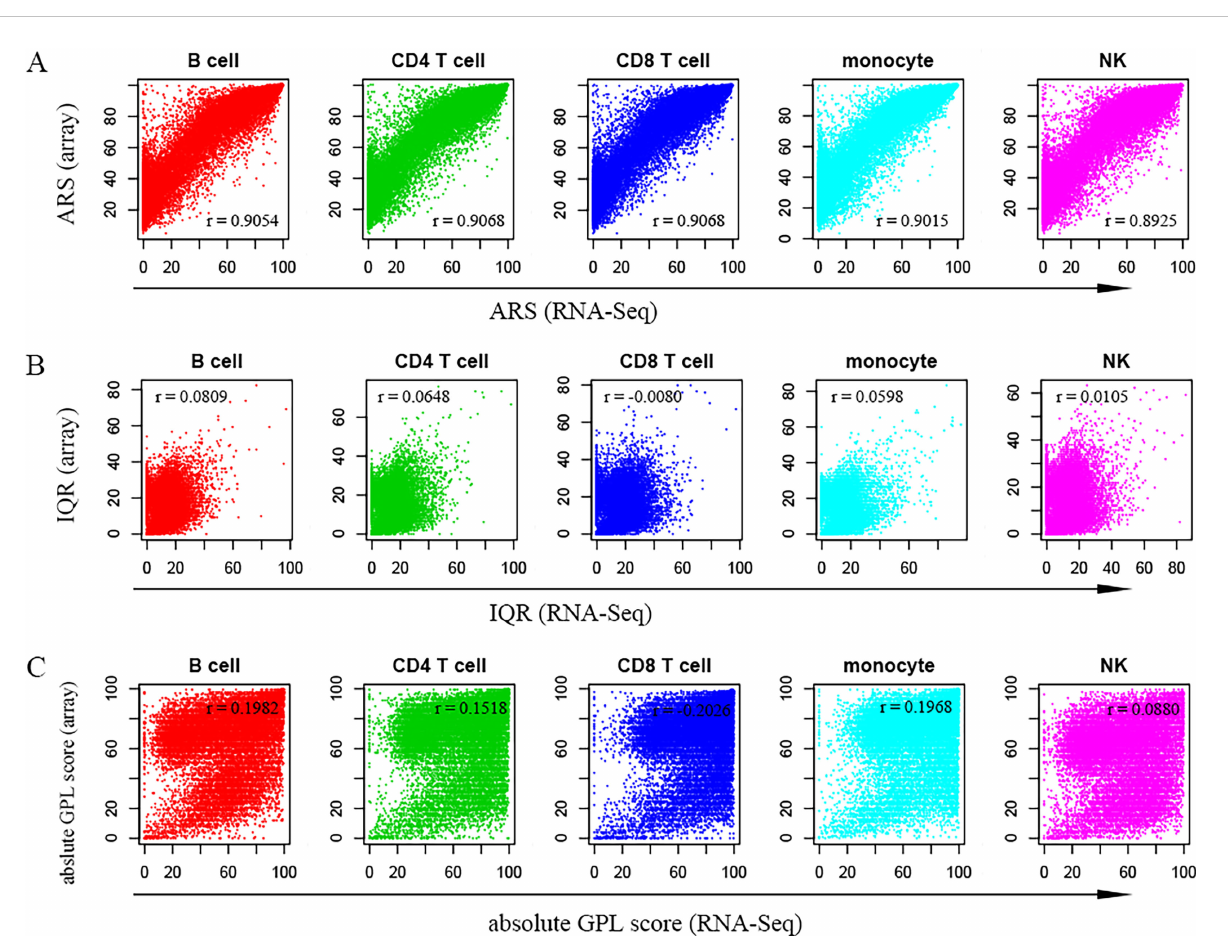
FIGURE 2 Scatter plots show the relationships between measured values calculated using RNA-Seq and microarray datasets. (A – C) represent the average rank score (ARS), interquartile range (IQR) and absolute GPL score, respectively. In each panel, the x-axis indicates values from RNA-Seq data, while the y-axis indicates values from microarray data. The Pearson coef fi cient (r) is shown in each panel. Therefore, there is a high linear correlation between the ARSs of the two